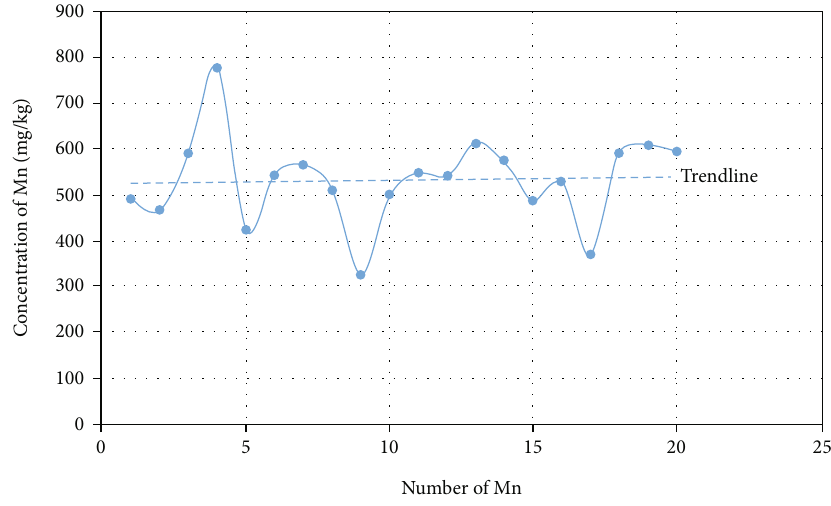
Figure 7: Scatter plot showing the concentration distribution trend of